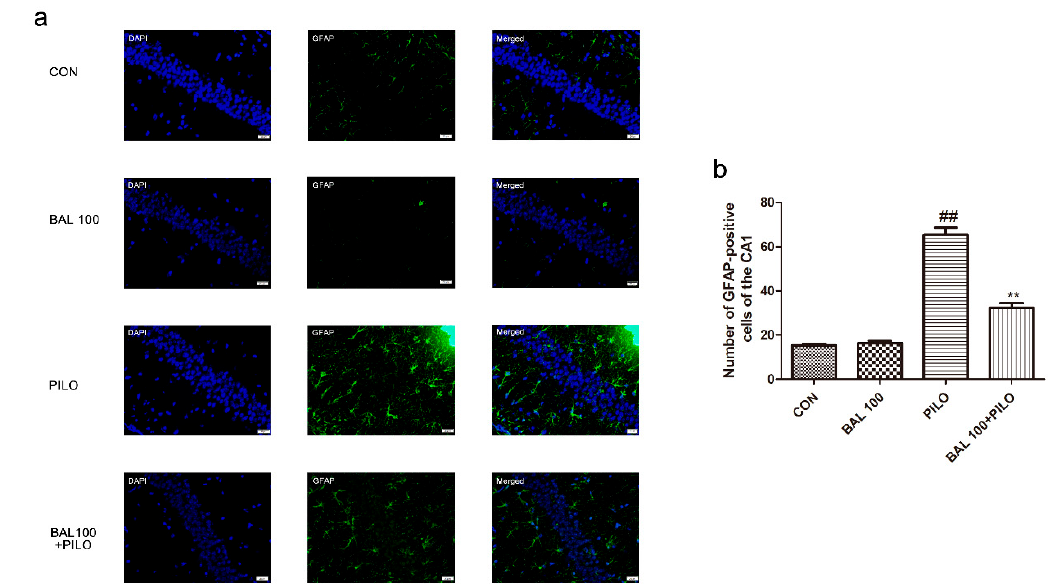
Figure 5. Effect of BAL on astrocyte activation in the hippocampus at 72 h after convulsion are shown with high power ( × 400 magnification). GFAP-positive cells in CA 1 are shown for CON group, PILO group, and BAL 100 group, BAL 100 + PILO group ( a ). Bar: 20 µ m. Quantitative analysis of GFAP-positive cells in the hippocampal CA 1 ( b ). Results are expressed as mean ± SEM. ## p < 0.05 (Student-Newman-Keuls) as compared to control group, ** p < 0.01 (Student-Newman-Keuls) as compared to the PILO group ( n = 6, One-way ANOVA and the